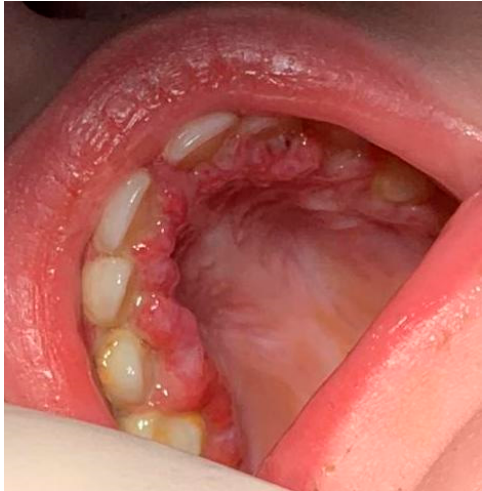
Figure 1. First oral clinical presentation (T0).